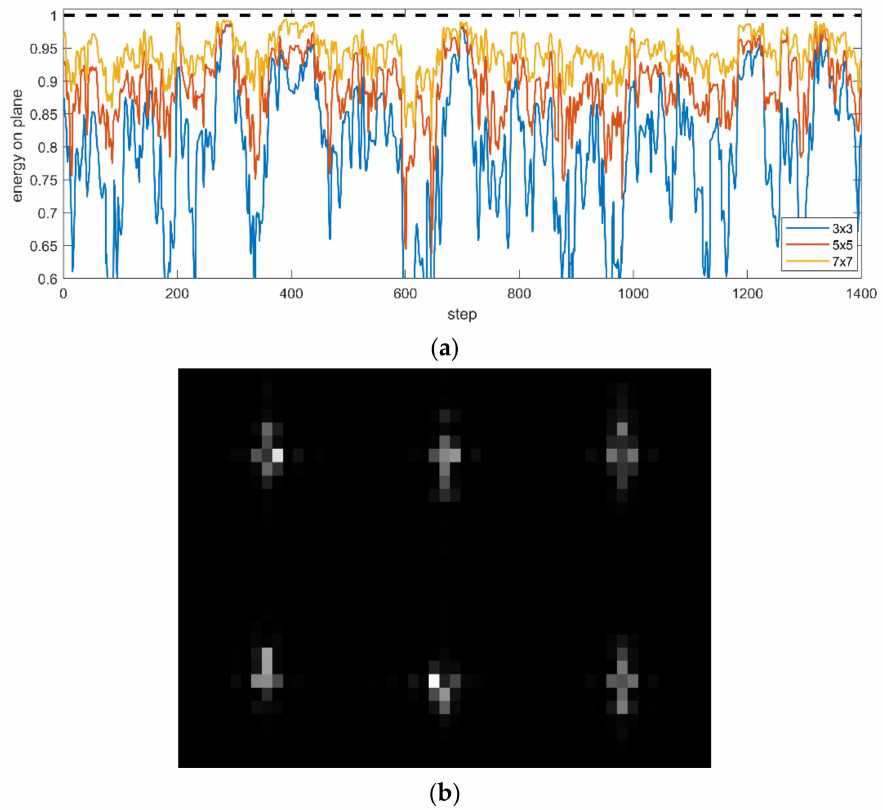
Figure 11. Simulation results of photon energy scattering: ( a ) Energy proportion in different ranges; ( b ) image blurring caused by photon energy